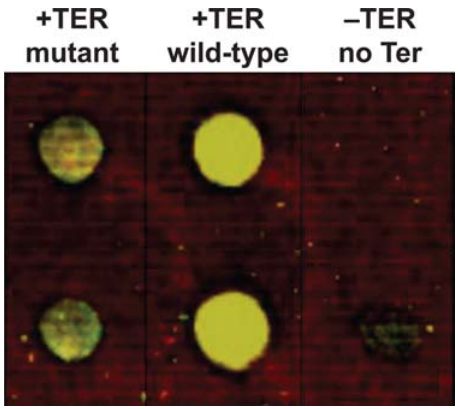
Figure 2. Exploiting the specificity of Tus:Ter interaction. Plasmid vectors encoding a green florescent protein (GFP)- TUS - poly-histidine fusion protein and a Ter sequence containing a point mutation (pMUT), a wild-type Ter sequence (pNOMut), and no Ter sequence were immobilized on the surface of a microarray, incubated in a cell-free rabbit reticulocyte transcription/translation extract, and hybridized with Cy-labeled anti-histidine antibody.